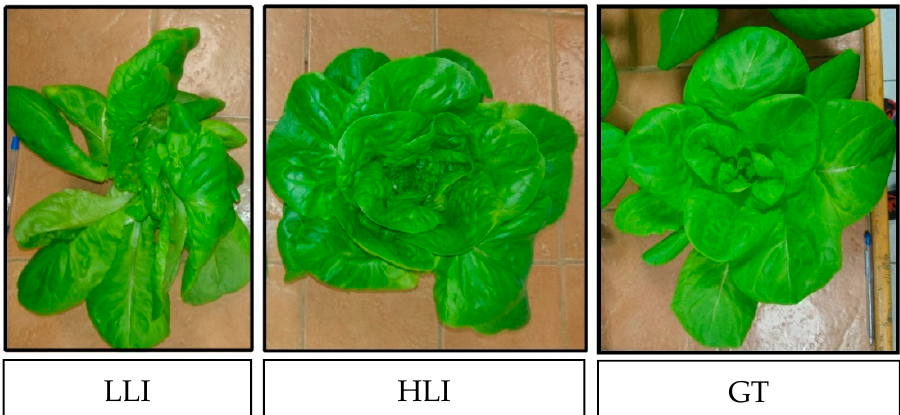
Figure 3. Average appearance of lettuce plants from each growing treatment at the harvest stage. Judged by visual inspection, the low light intensity in the Photon Rack (LLI) produced “vortex-like” morphology. The plants in the HLI and GT treatments were morphologically “normal”, while in the HLI they had a greener appearance. HLI, High light intensity; LLI, Low light intensity; GT, Glasshouse Table 2. Effect of different light intensities and hydroponic cropping system on growth and development of lettuce ‘Glory’ grown in a vertical farming system and in a glasshouse during the winter. HLI, High light intensity; LLI, Low light inten- sity; GT, Glasshouse treatment.